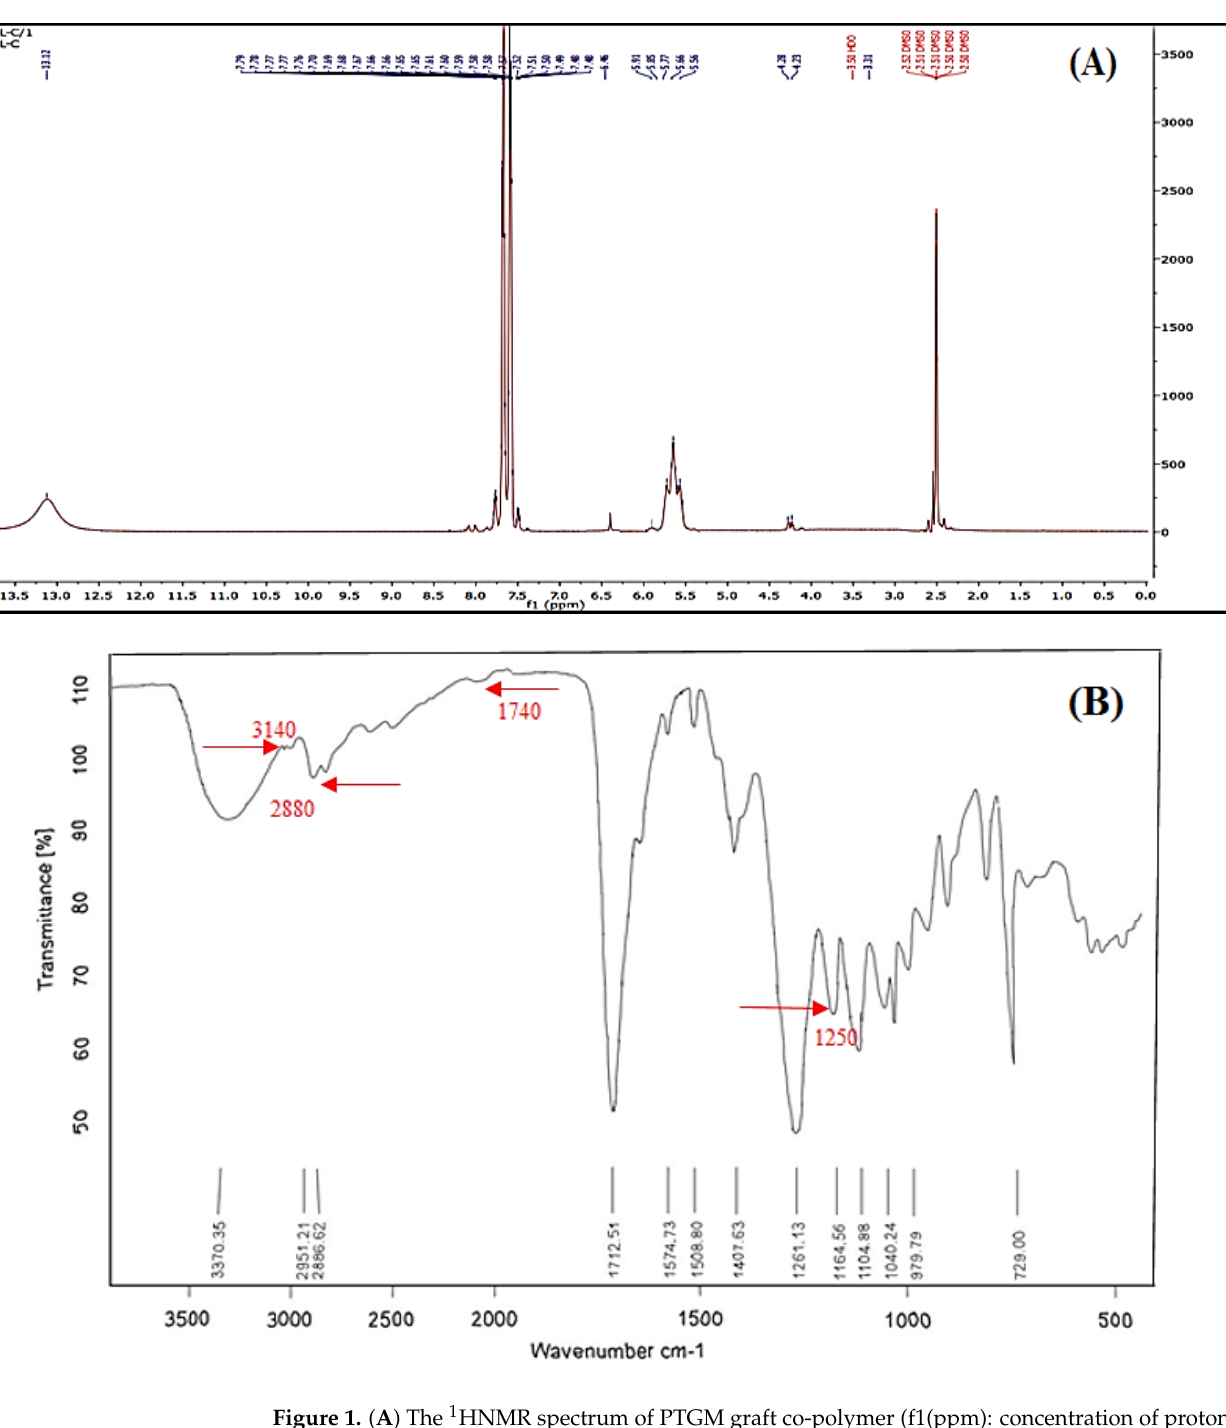
Figure 1. ( A ) The 1 HNMR spectrum of PTGM graft co-polymer (f1(ppm): concentration of proton in each peak). ( B ) The FT-IR spectrum of PTGM graft co-polymer.